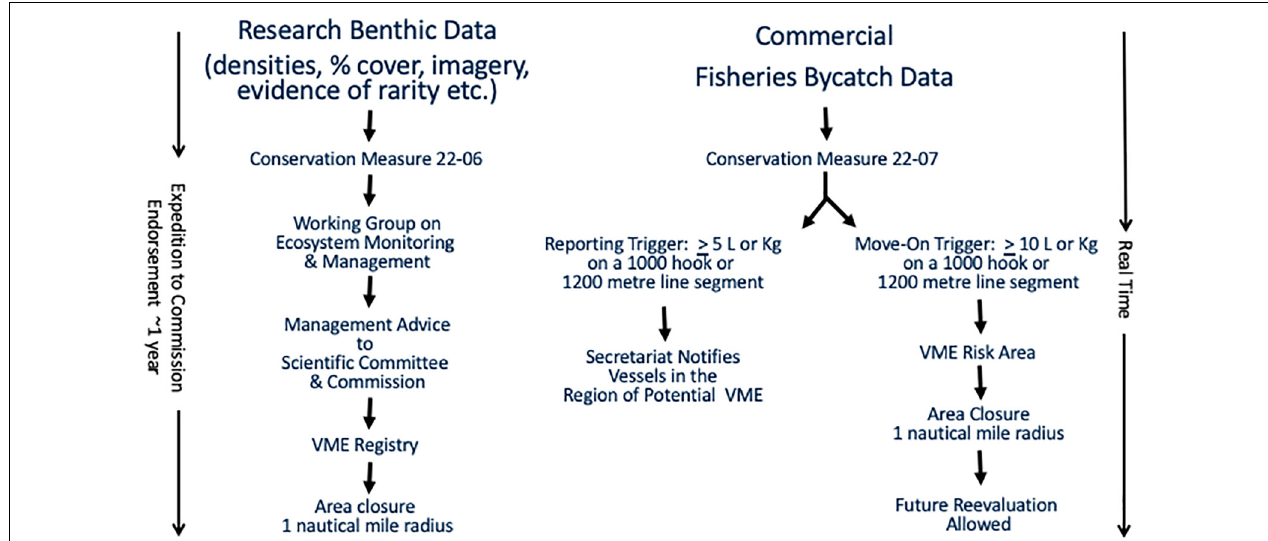
FIGURE 1 | CCAMLR VME reporting and registering